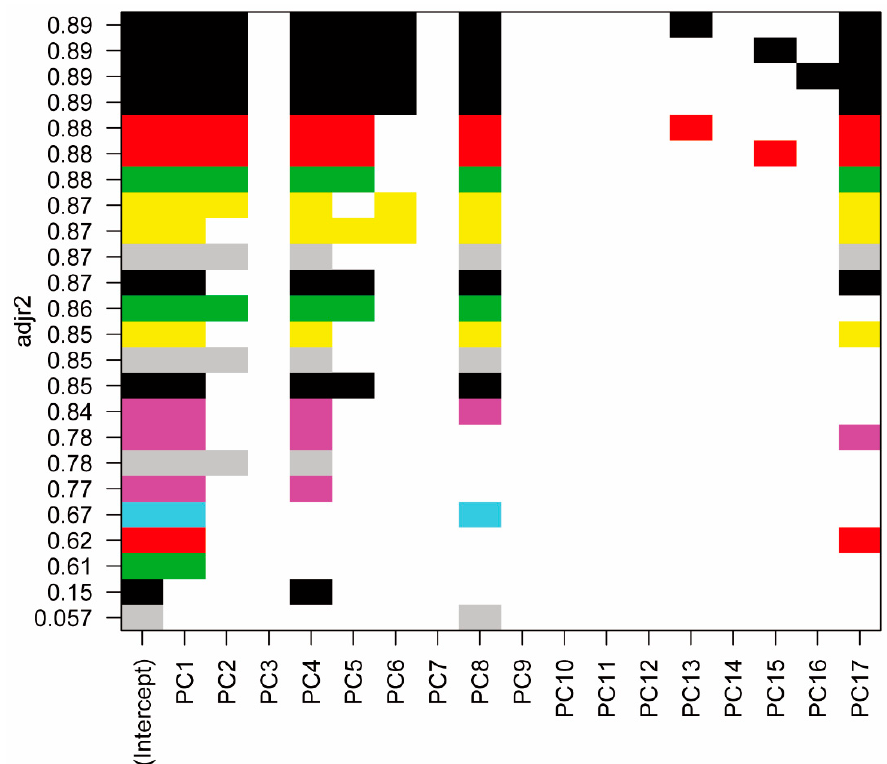
Figure 4. All-subsets regression.